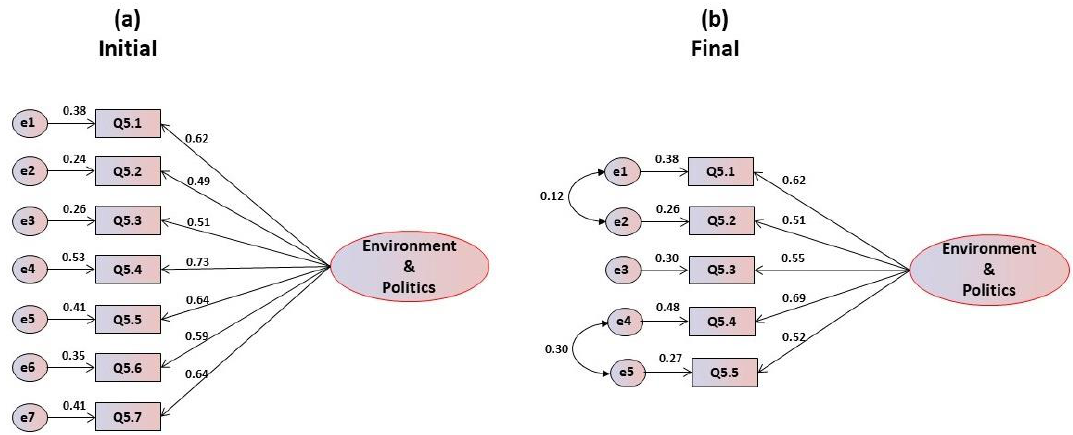
Figure 5. ( a ) Initial and ( b ) final models for the environmental and political motivations’ scale.